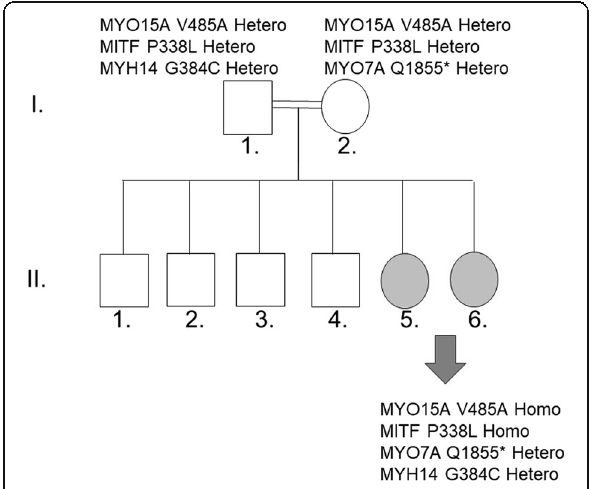
Fig. 1 Family ’ s phenotype and genotype. The pedigree of the enrolled family, with affected individuals marked in grey. Possible causative variants of the affected sisters and those of the parents are